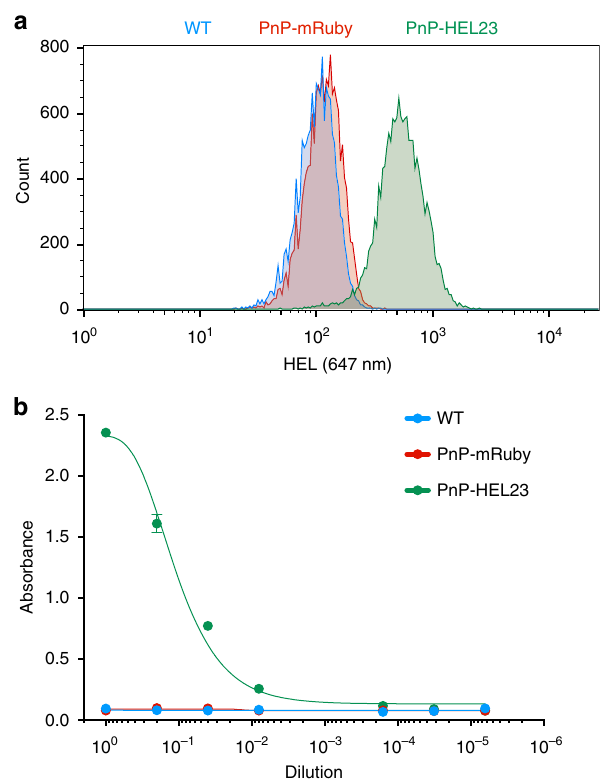
Figure 3 | Reprogrammed PnP cells surface express and secrete antigen- specific antibody. ( a ) Flow cytometry histogram shows reprogrammed hybridoma cells (PnP-HEL23) surface express antibody specific for cognate antigen hen egg lysozyme (HEL). ( b ) ELISA data show that PnP-HEL23 cells secrete antibody specific for HEL. One technical replicate was analysed for the control samples (WT and PnP-mRuby) and two replicates for the PnP- HEL23 cell line. A four-parameter logistical curve was fitted to the data by nonlinear regression. Data are presented as the mean and error bars indicate standard deviation. Throughout this figure, WTcells correspond to clone WEN1.3, PnP-mRuby cells correspond to clone 1E9.C3, PnP-HEL23 cells correspond to clone Y (for more details, see Supplementary Table